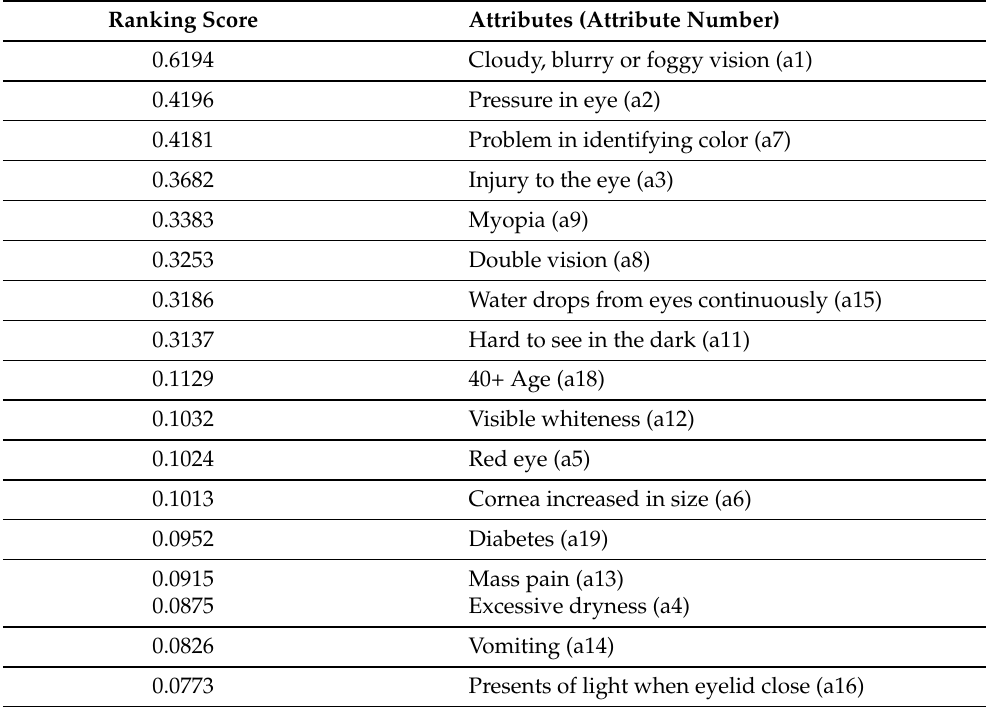
Table 5. Ranking of Features from Relief-based FS